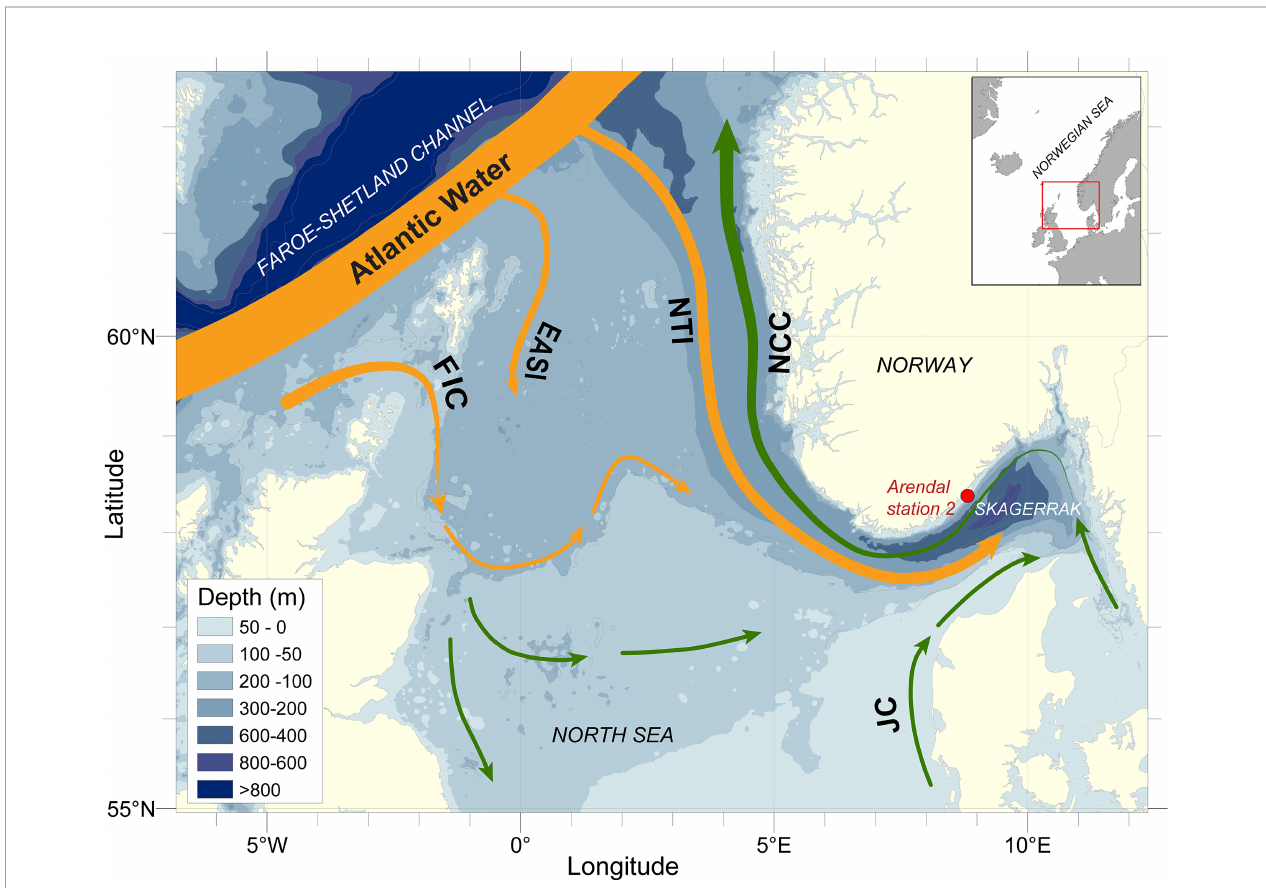
FIGURE 1 | North Sea and Skagerrak with main currents and location of Arendal Station 2 monitoring site. NTI: Norwegian Trench Atlantic In fl ow; NCC, Norwegian Coastal Current; ESAI, East Shetland Atlantic In fl ow; FIC, Fair Isle Current; JC, Jutland Current. Inset map shows the location of the Skagerrak area relative to adjacent